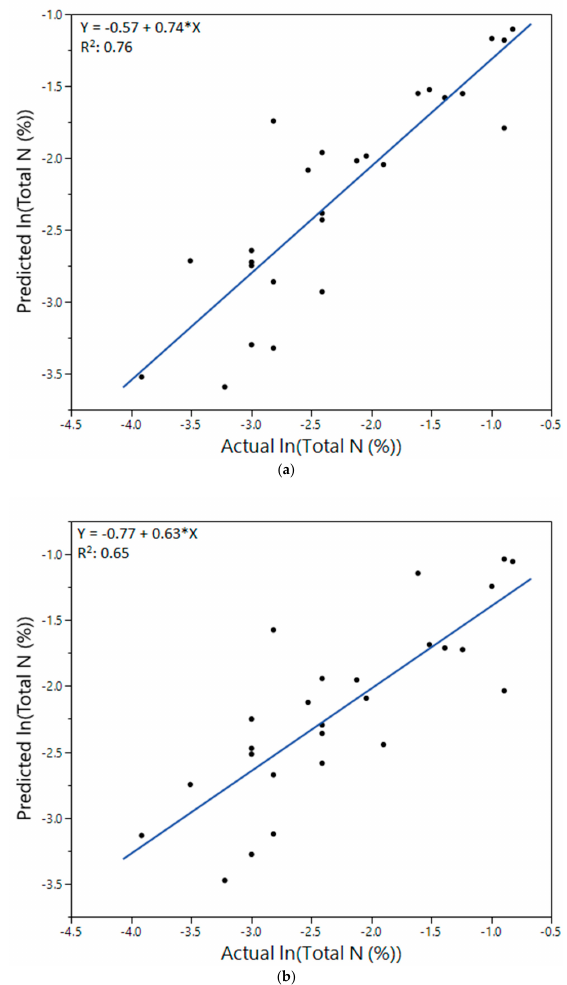
Figure 5. Plots of predicted lnTN (%) versus actual lnTN (%) for validation data sets for dry soil samples of Alfisols using ( a ) models which included depth and color variables ( p -value < 0.001), and ( b ) models which included only color variables as predictors ( p -value < 0.001). Separate multiple regression analyses were conducted on 70% ( n = 42) of Entisols using sample horizon lower depth together with color variables, and using color variables only, as predictors to predict lnSOC (%) and lnTN (%). Again, the color variable a * was excluded from analysis due to its large correlation with the other predictors. The lnSOC (%) prediction model, which included depth and color variables, indicated that depth and L * were significant predictors of lnSOC (%) while b * was marginally insignificant (Table 3). Cross-validation resulted in a MSPE of 0.48 ( R 2 = 0.64; Figure 6a, Table 3). The lnSOC (%) prediction model, which included color variables only, indicated that L * was a significant predictor of lnSOC (%) while b * was not (Table 3). Cross-validation resulted in depth and color variables, indicated that depth, L *, and b * were significant predictors of lnTN (%) (Table 4). Cross-validation resulted in a MSPE value of 0.23 ( R 2 = 0.60; Figure 7a, Table 4). The lnTN (%) prediction model, which contained color variables only, indicated that L * and b * were